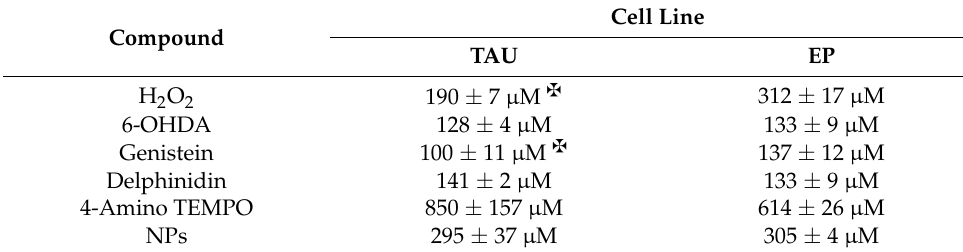
(cid:122) p < 0.05 (TAU vs. EP).